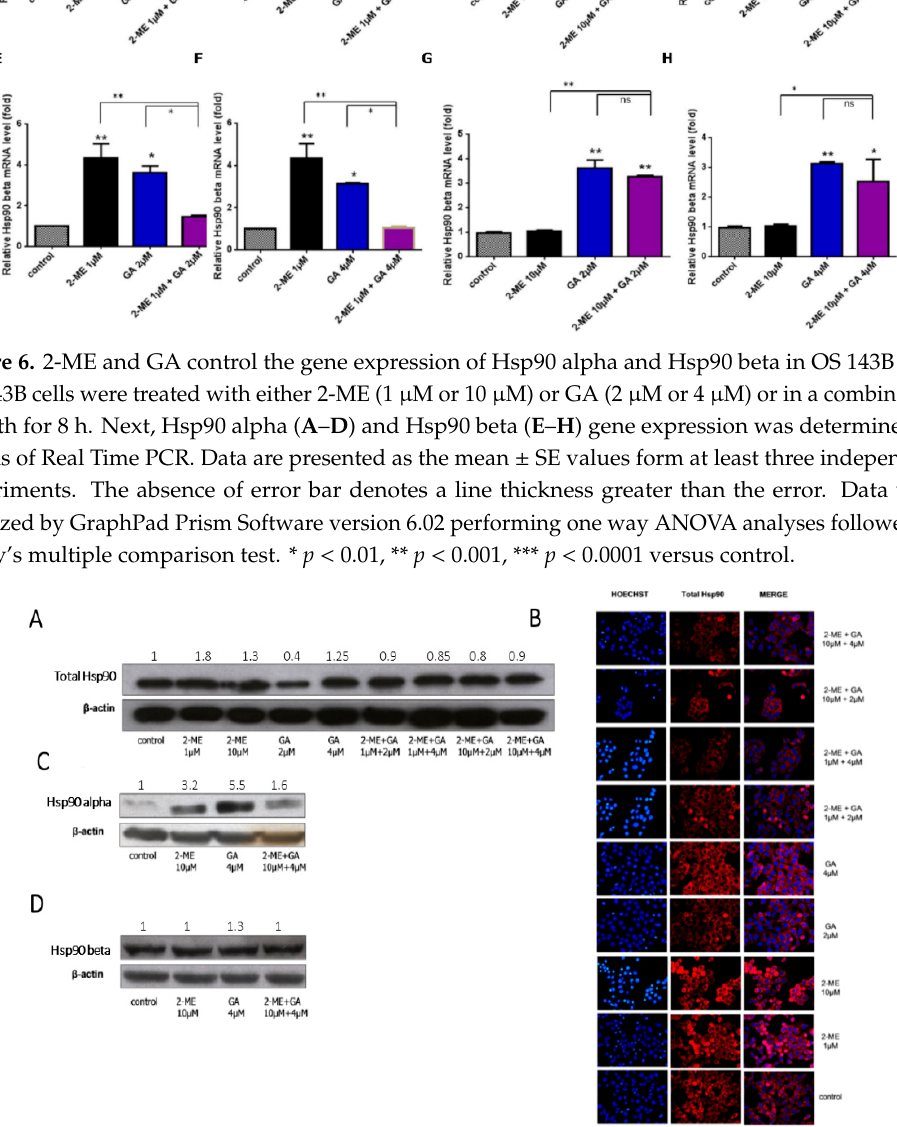
Figure 7. 2-ME and GA regulates the Hsp90 protein level in OS 143B cells. OS 143B cells were treated with vehiculum (Control), 2-ME (1 µ M, 10 µ M) or GA (2 µ M, 4 µ M) or combination of both for 8 h. Consequently, total pool of Hsp90 protein in OS 143B was determined by western blotting ( A ) and immunofluorescence ( B ), respectively. Cell nuclei were shown in blue, Hsp90 immunoreactivity in red, merged images of both in light red. Original magnification × 40. While the protein level of Hsp90 alpha ( C ) and Hsp90 beta ( D ) was evaluated by western blotting. Each experiment was performed at least three times. The representative data from three experiments are presented.